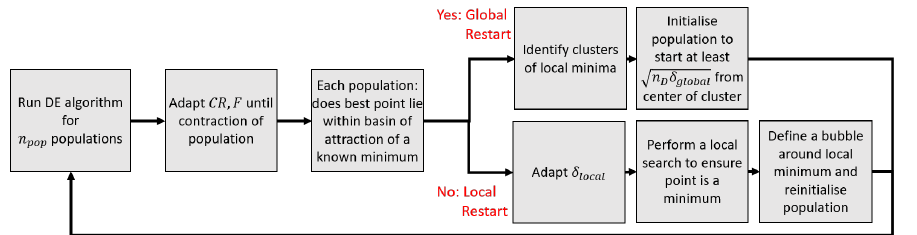
Figure 3. Description of the Multi-Population Adaptive Inflationary Differential Evolution Algorithm